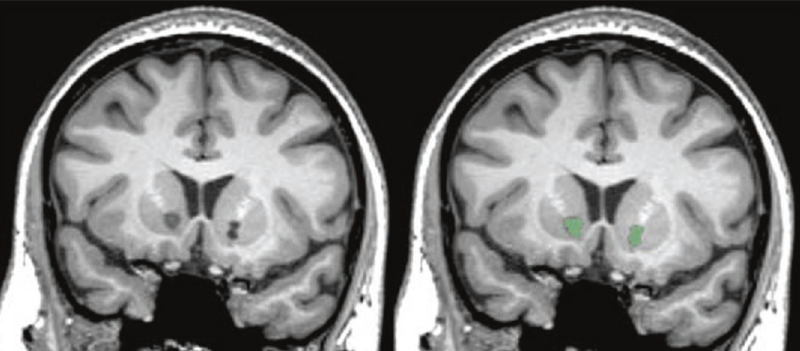
Fig. 1 Bilateral capsulotomy lesions. Left . A coronal slice of bilateral capsulotomy lesions in native space. Right . The hand-traced mask (green) for this